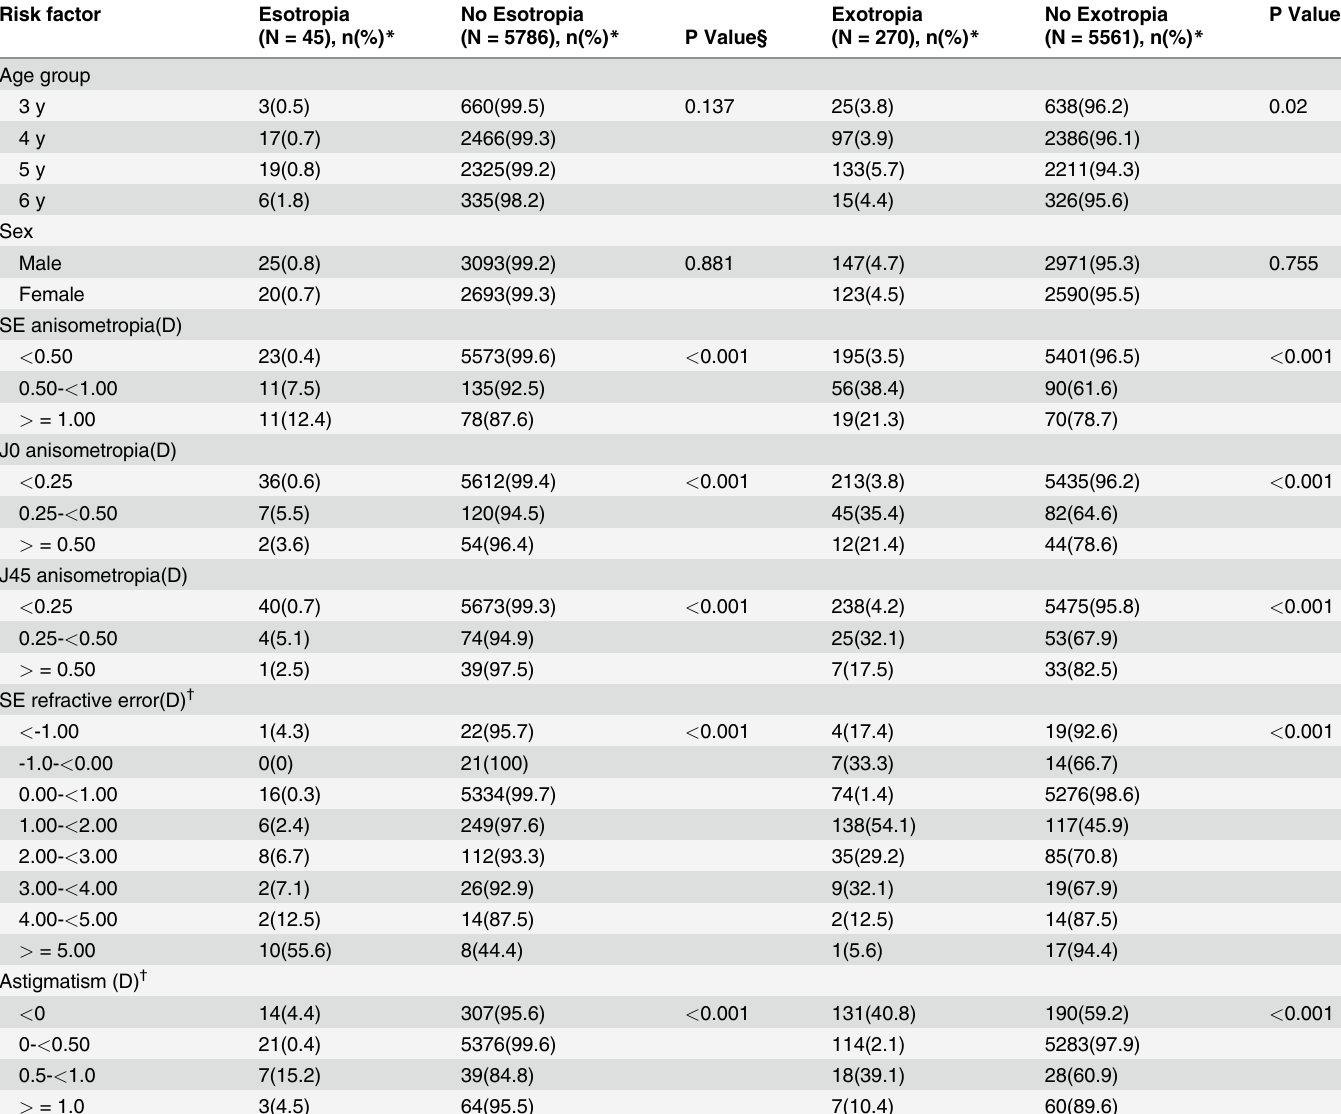
Table 1. Frequency Distributions of Refractive Error Risk Factors in 3 to 6 Years-Old Children with and without Strabismus in the Nanjing Pediatric Vision